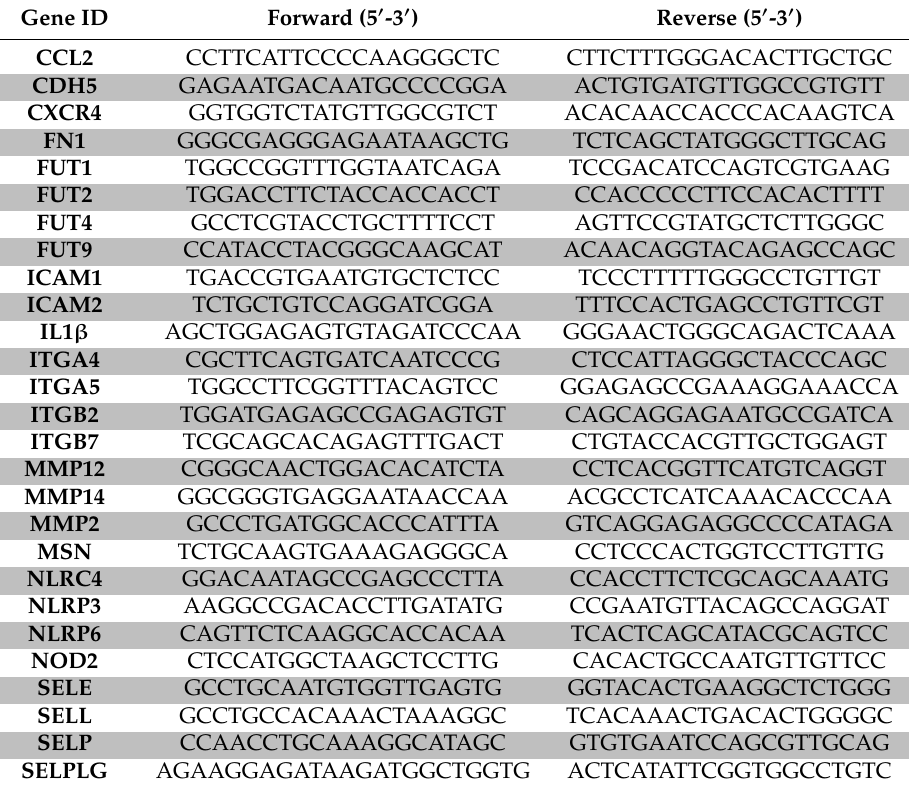
Table 3. SybrGreen primer sets used in QPCR experiments for human samples.